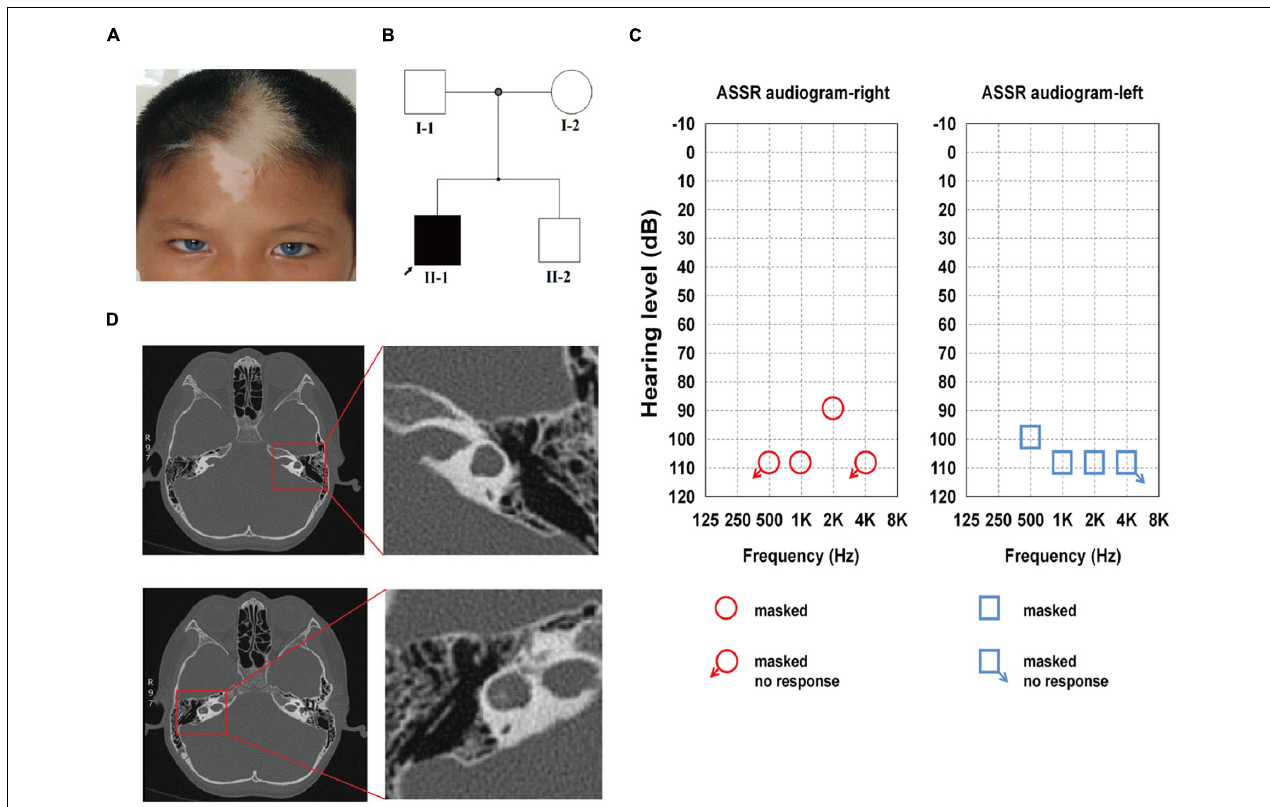
FIGURE 1 | Family history and clinical features of the proband. (A) The proband showed bilateral brilliant blue irides, patchy depigmented areas on forehead and white forelock. (B) The pedigree indicates that only Family II-1 had the WS-associated phenotypes, which are marked in black. (C) ASSR of the left ear: 100, 110, and 110 dB at 0.5, 1, and 2 kHz, respectively, the other frequencies showed no response. ASSR of the right ear: 110 and 90 dB at 1 and 2 kHz, respectively, the other frequencies showed no response. (D) Enlarged vestibule and semicircular canal abnormalities on both sides are shown on high-resolution axial CT in the red